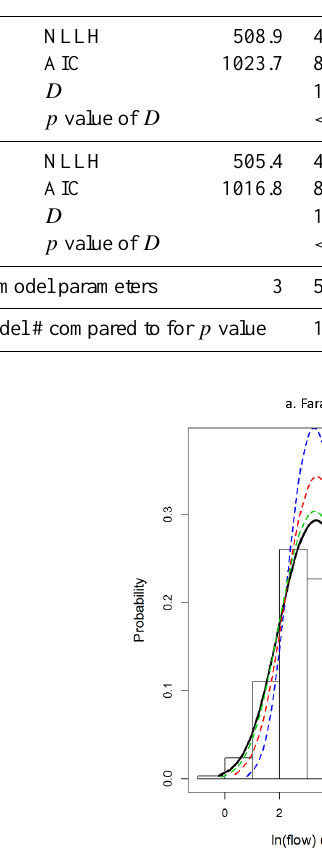
Figure 2. Probability density function of fitted stationary (solid black) and non-stationary (dashed) GEV models compared to historical VIC-simulated flow